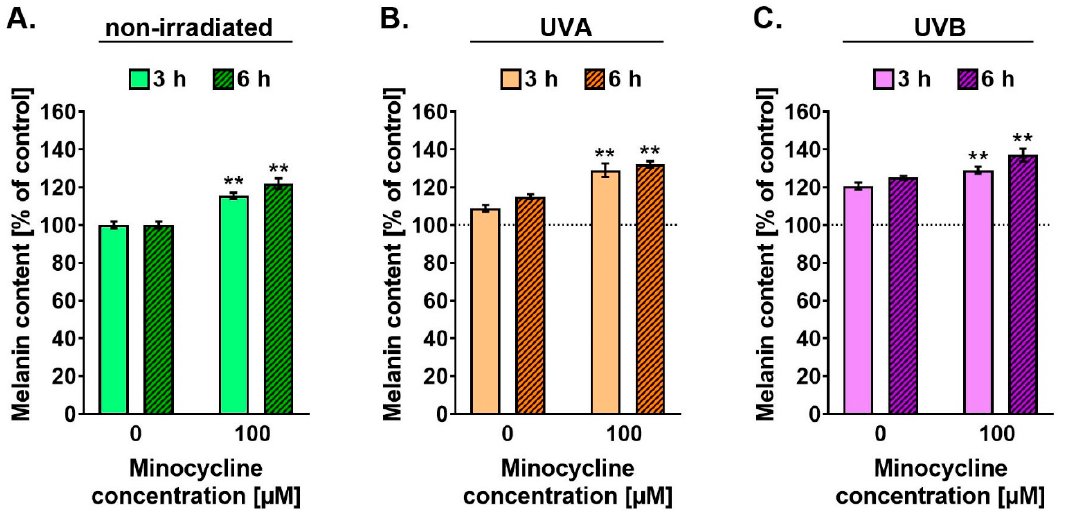
Figure 5. Minocycline causes an increase in melanin content in melanocytes ( A ) non-irradiated ( B ) exposed to UVA radiation ( C ) exposed to UVB radiation. Melanin content was normalized using total protein concentration. The results are presented as the percentage of control. ** p < 0.005.